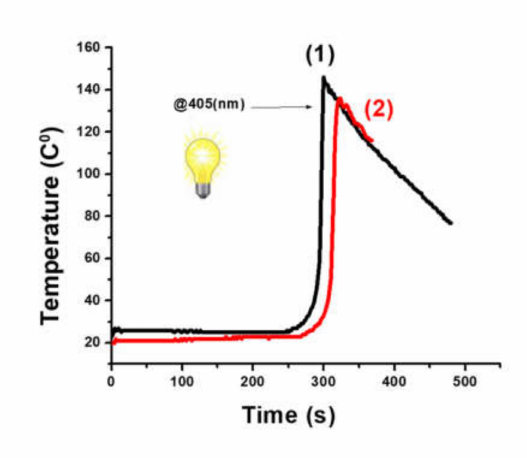
Figure 4. Optical pyrometric measurements (temperature vs. time after mixing; 4 mm thick sample) under air using a Redox Initiating System (RI)S Mn(acac) 2 / DPS (1 / 1 wt%); (1) with light (LED at 405 nm) and (2) without